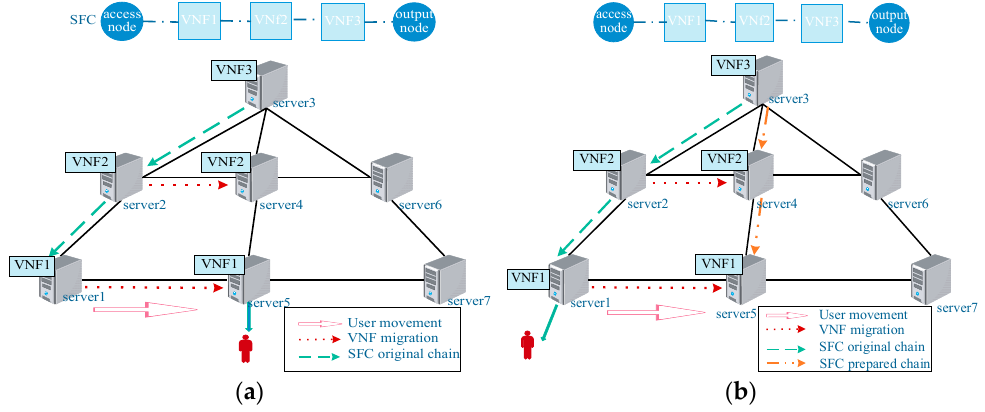
Figure 3. Two migration strategies: ( a ) soft migration; ( b ) softer migration.